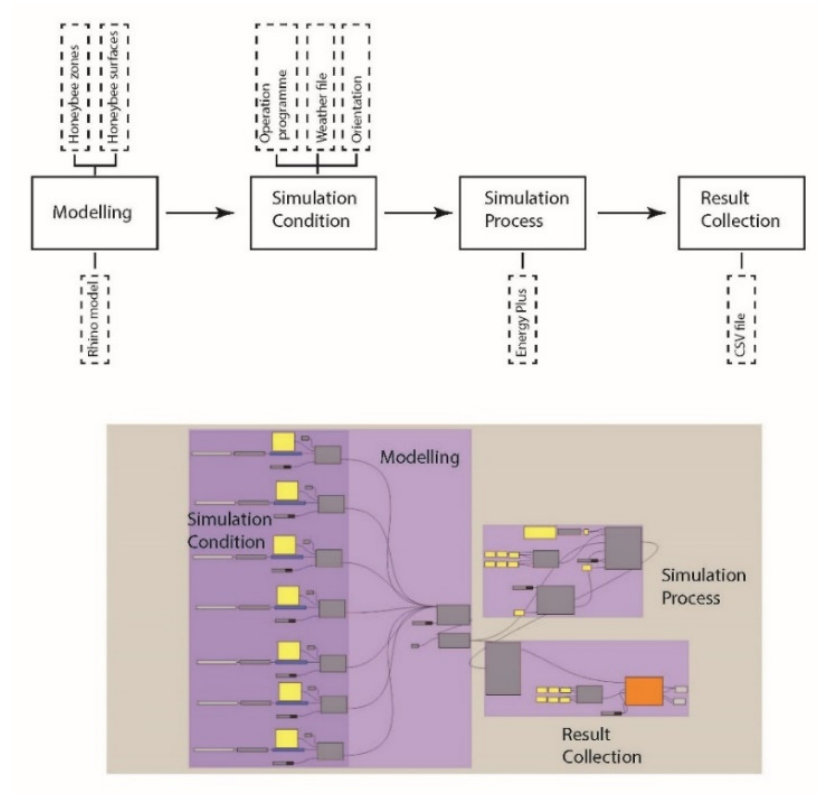
Figure 4. Energy simulation using Grasshopper.